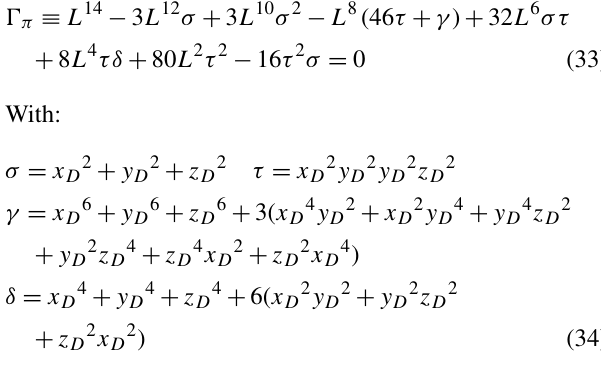
s 1 = s 2 = h corresponds to the case in which the chains 1 and 2 have the same direction. In the case of the equiva- lent manipulator, this situation ( r 1 = r 2 = 0) implies that two bars are coincident. The intersection point of the three lines, s 1 = s 2 = s 3 = h , corresponds to the subcase of three legs